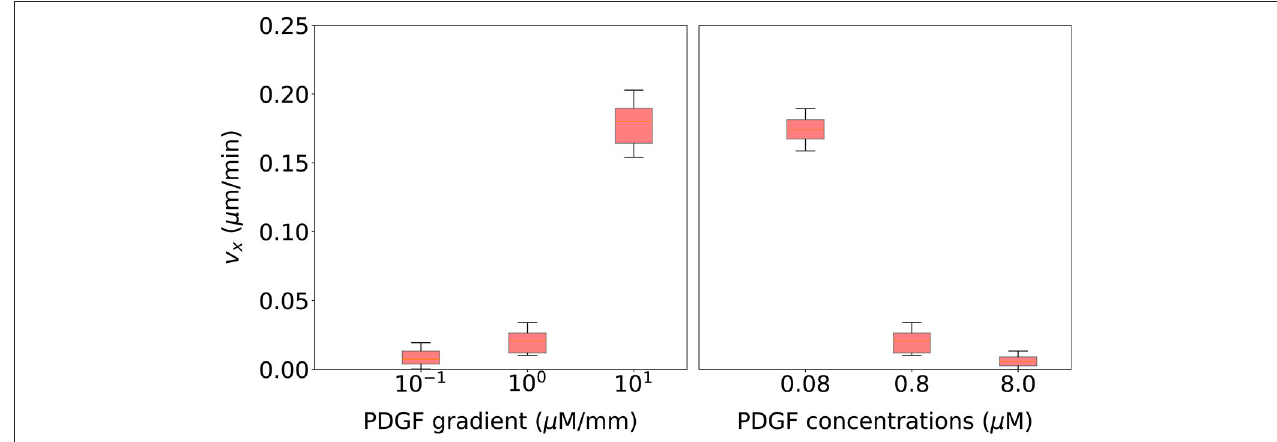
FIGURE 10 | Cell migration speed statistical analysis for 20 simulations using the parametrization selected during the calibration process and associated with six different extracellular environments. (Left) three of these extracellular environments include different PDGF gradients (10 − 1 , 10 0 , 10 1 µ M / mm ) but a fixed PDGF concentration at the initial cell’s position (0.8 µ M ). (Right) three extracellular environments include a fixed PDGF gradient (10 0 µ M / mm ) but different PDGF concentrations at the initial cell’s position (0.08, 0.8, and 8.0 µ M